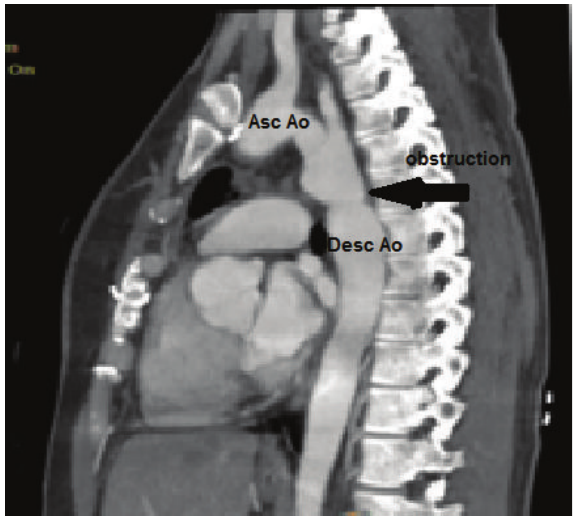
Figure 3: Computed tomography angiography demonstrates the postductal coarctation of the aorta. The descending aortic arch is tortuous and the diminutive left subclavian artery arises proximal to the